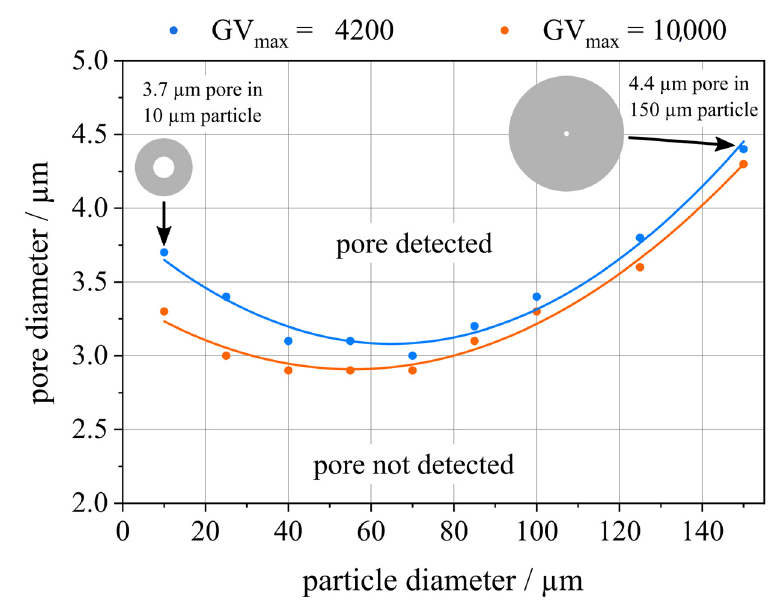
Figure 6. Diameter of the minimum pore sizes detectable by digital radiography in metal powder particles with diameters between 10 µm and 150 µm. The schematic insets are not to scale.